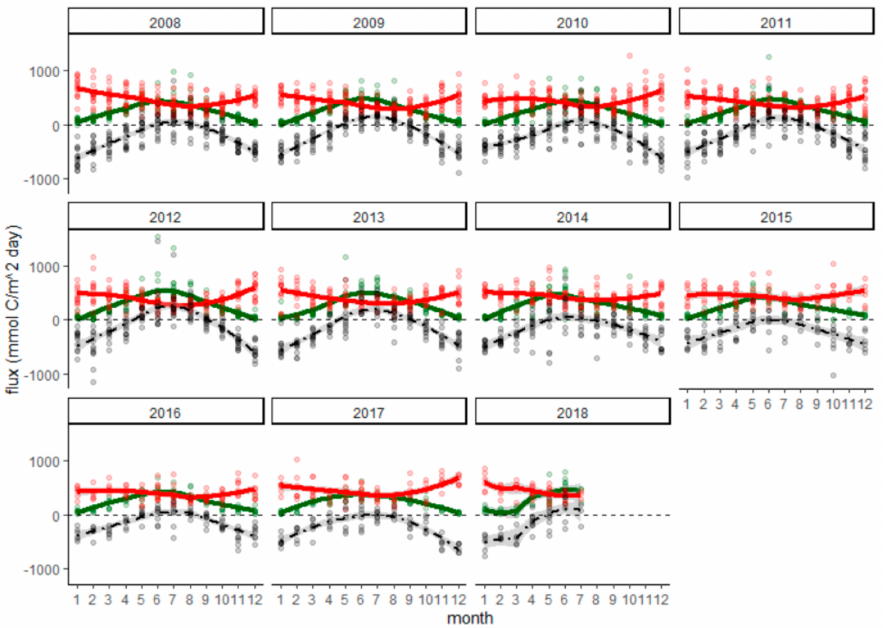
Figure 7. Daily production (P, green) and respiration (R, red) and the difference (NEPP, P-R) expressed in mmol C m − 2 day − 1 for each month and year. Horizontal dashed line at intercept = 0 represents P = R. Table 3. Differences between production and respiration (P-R) expressed in tons of CO 2 eq per unit area for each water body and each year. NA values represent missing data. The last column represents median values of the differences scaled up to the whole area of the lagoon based only on the water bodies for which data were available in this study. The last row represents the median value of the differences scaled up to the whole basin area. The last column represent the median value for the whole period considered for the whole lagoon. Negative values represent higher respiration. N.B. median values are calculated excluding